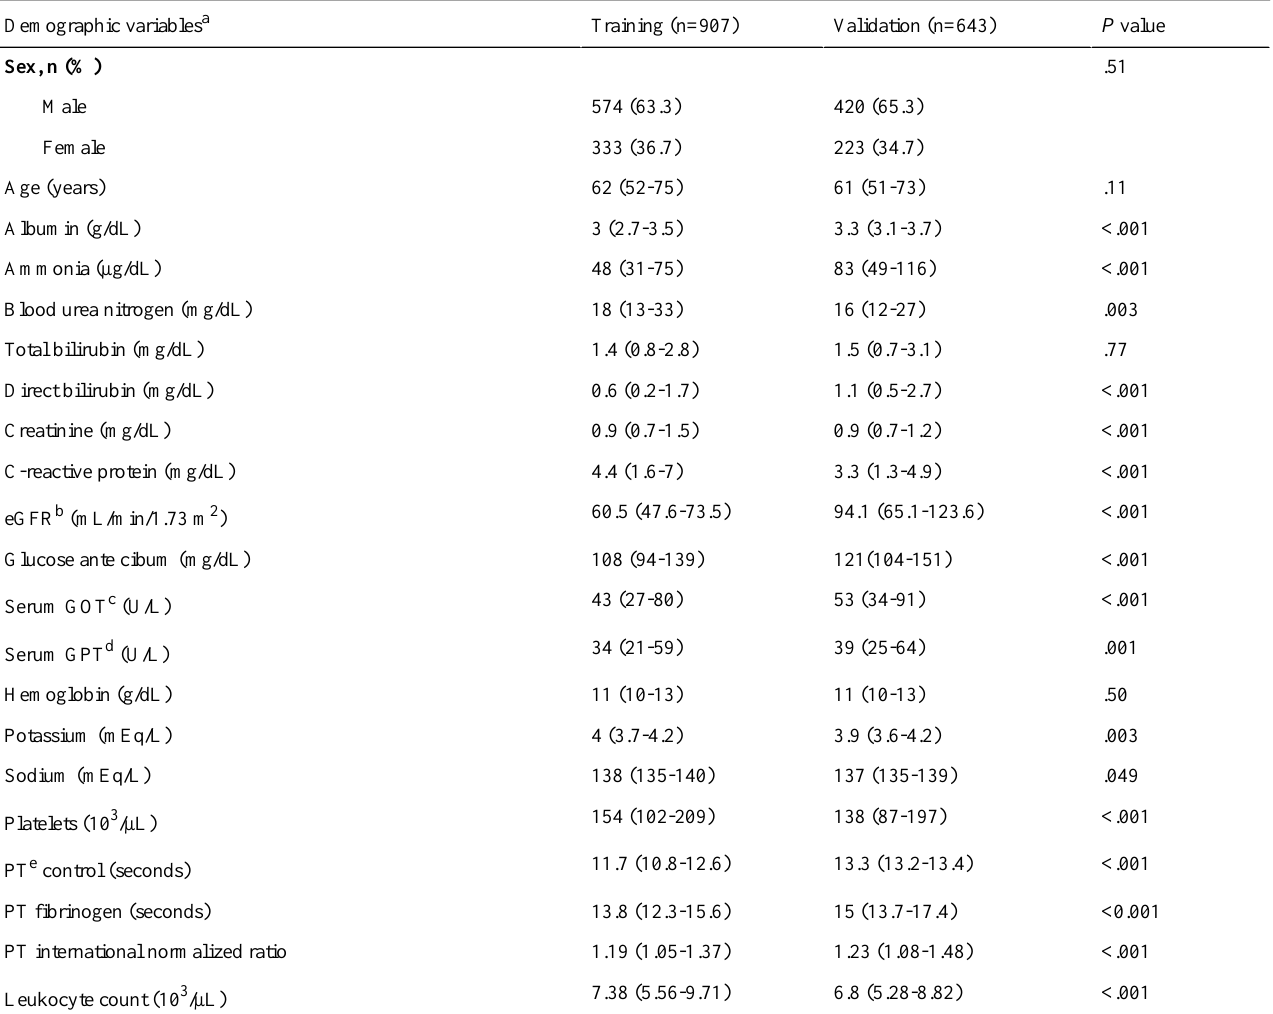
Table 3. Demographic and laboratory characteristics of patients with noncancerous liver diseases in the training and validation